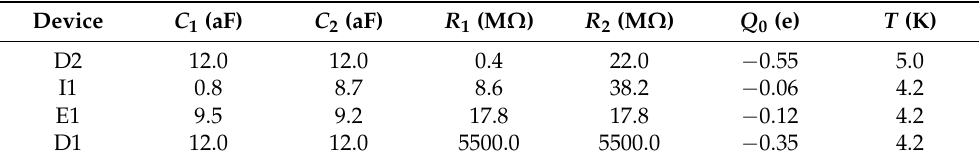
tions. A broad dispersion was found in the parameters: the total capacitance varied over two orders of magnitude from 0.84 to 62.7 aF, while the total resistance varied over four orders of magnitude from 0.02 G Ω to 72 G Ω